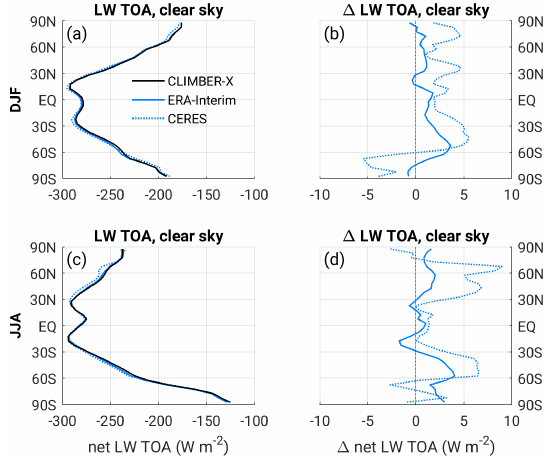
Figure A4. Zonal mean net longwave radiation at the top of the at- mosphere for clear-sky conditions as computed by the CLIMBER- X radiation code in an offline set-up compared to ERA-Interim re- analysis (Dee et al., 2011) and CERES satellite observations (Loeb et al., 2018). Panels (a) and (b) are for December–January–February and panels (c) and (d) are for June–July–August. Panels (a) and (c) show absolute values, while panels (b) and (d) show model biases.